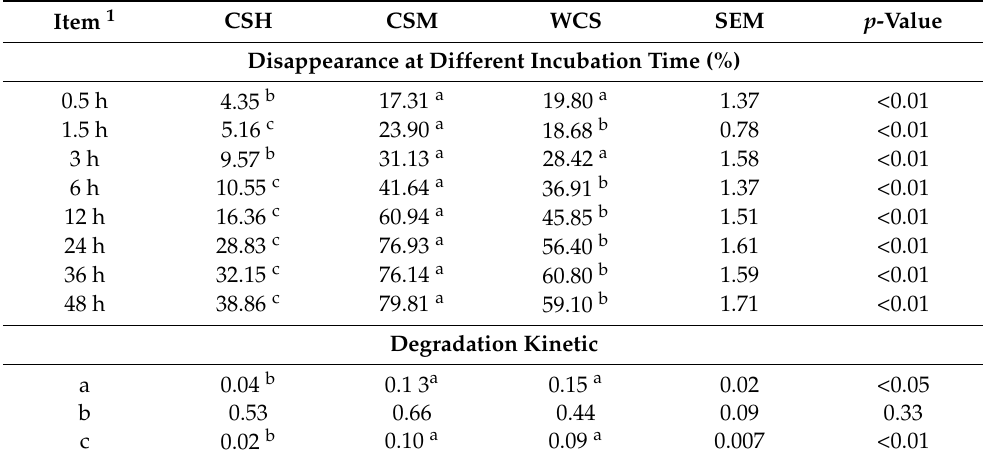
Table 2. In vitro dry matter degradability of cottonseed and its